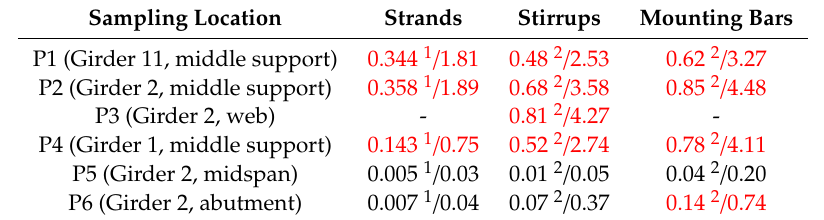
Table 3. Chloride concentrations at the level of reinforcement, in wt% of concrete / wt% of cement Sampling Location Strands Stirrups Mounting Bars P1 (Girder 11, middle